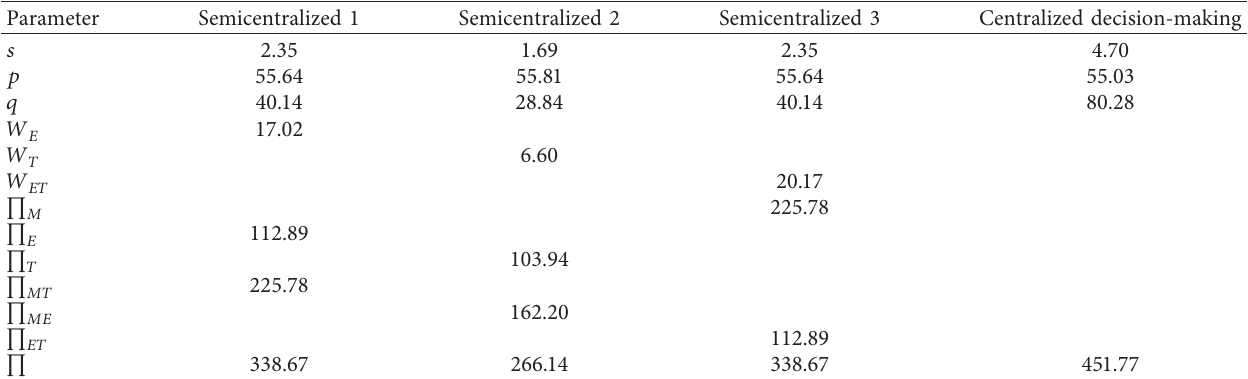
Table 4: Optimal solution and profit with different decision models.